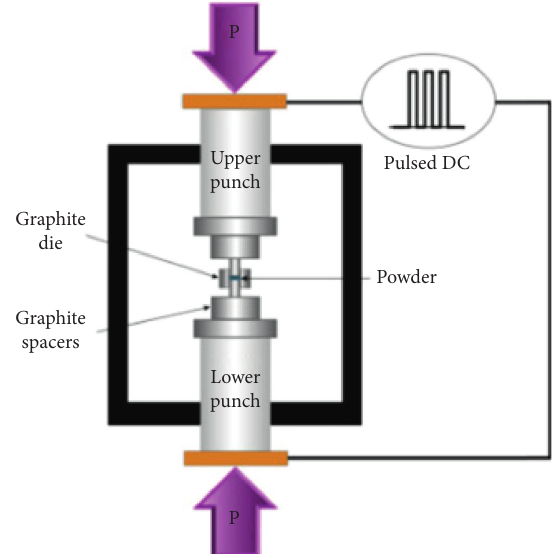
Figure 4: Schematic of a typical SPS processing system